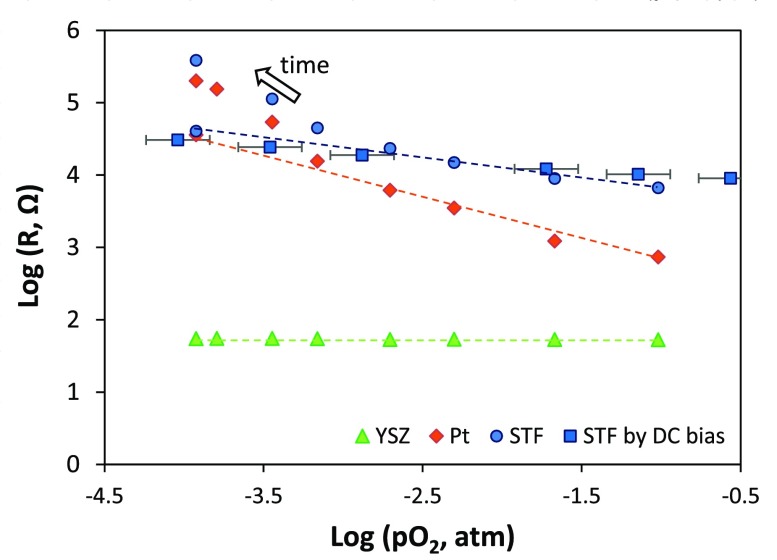
Oxygen partial pressure dependence of high frequency (YSZ), medium frequency (Pt counter electrode) and low frequency (STF) resistances, from equivalent circuit fitting of the impedance spectra, for the porous Pt/YSZ/STF/porous Pt cell at 600 °C. Dashed lines indicate guides to the eye showing the slopes for initial data prior to more significant degradation (~0 for YSZ, −0.61 for Pt, and −0.28 for STF). Increasing deviation from these slopes were observed for the Pt and STF contributions after increasingly long times (>100 h).